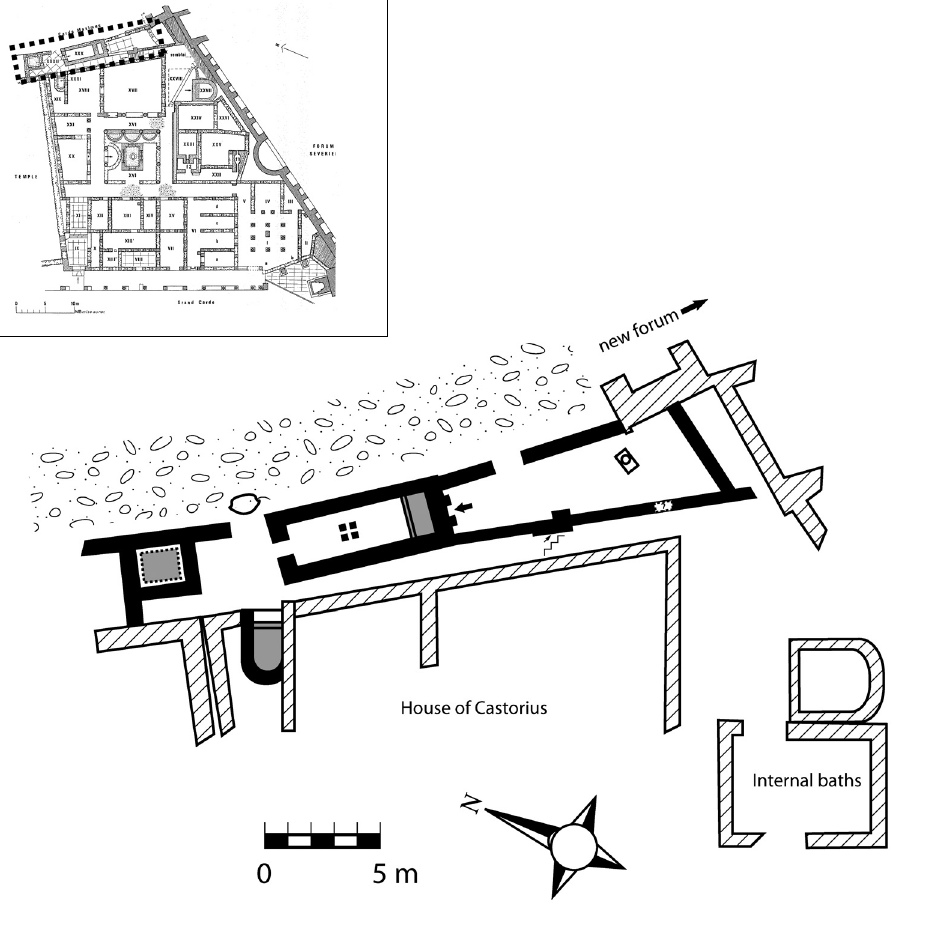
Figure 4: The baths of the House of Castorius in Cuicul (after Blanchard-Lemée 1975, fi g. 62).